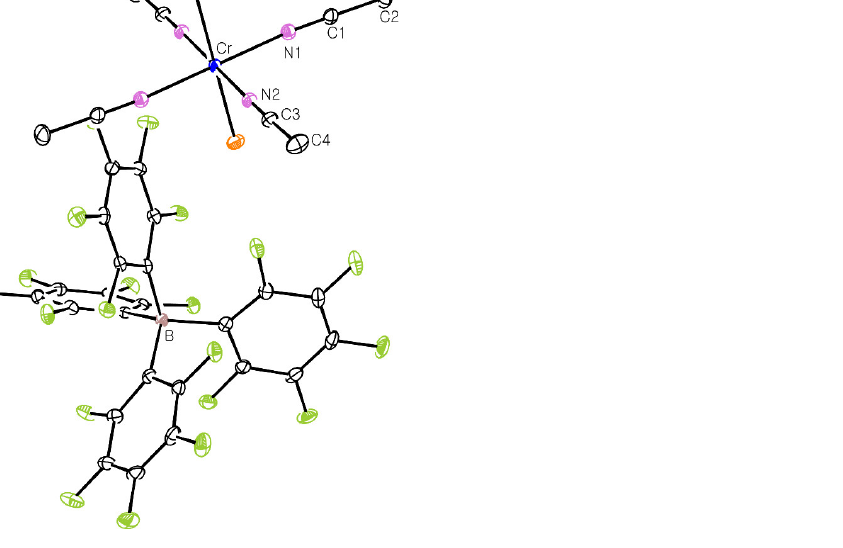
Figure 5. X-ray structure of [(CH 3 CN) 4 CrCl 2 ] + [B(C 6 F 5 ) 4 ] − . Selected bond distances (Å) and angles